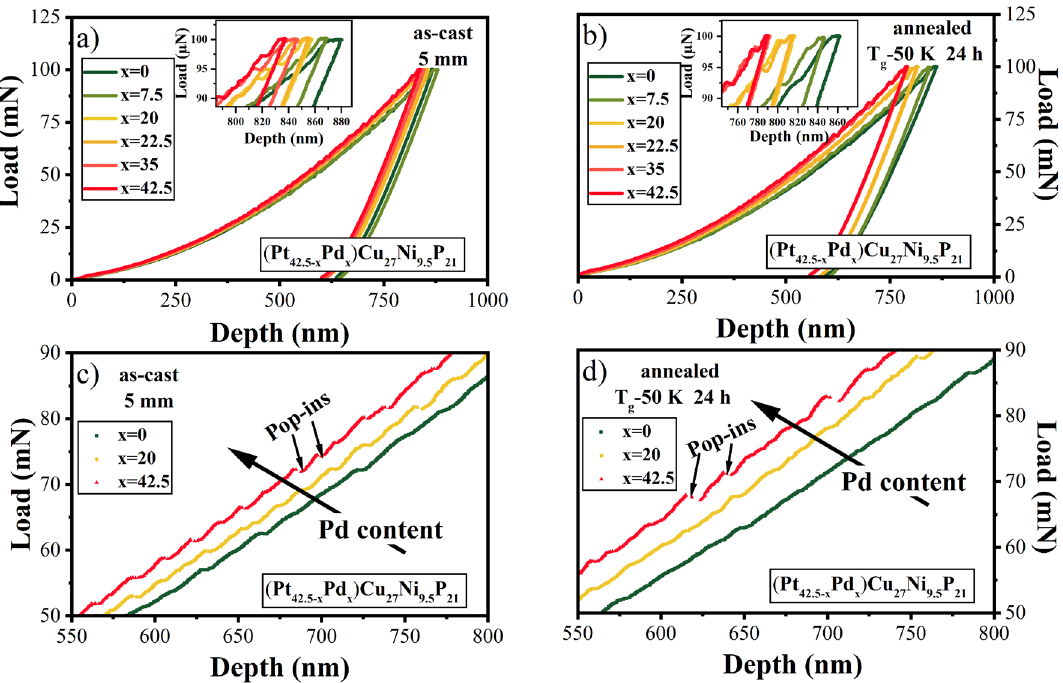
Figure 1. Nano-indentation load-depth plots for Pt 42.5−x Pd x Cu 27 Ni 9.5 P 21 bulk metallic glasses as a function of Pd content (i.e., x = 0,7.5, 20, 22.5, 35, 42.5); ( a ) in the as-cast state of a 5 mm rod and ( b ) after isothermal annealing at T g -50 K for 24 h; The insets in parts ( a ) and ( b ) show the zoomed in view of the loading curves; ( c ) and ( d ) show serrated behavior for